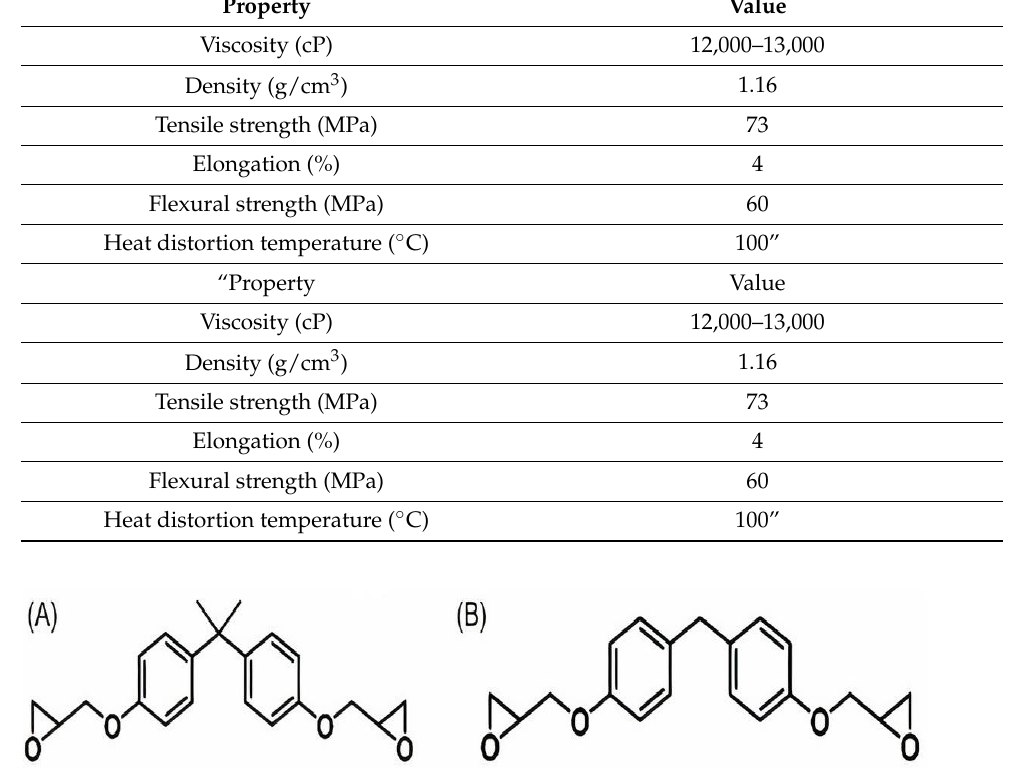
Table 3. Characteristics of epoxy resin [22,189].